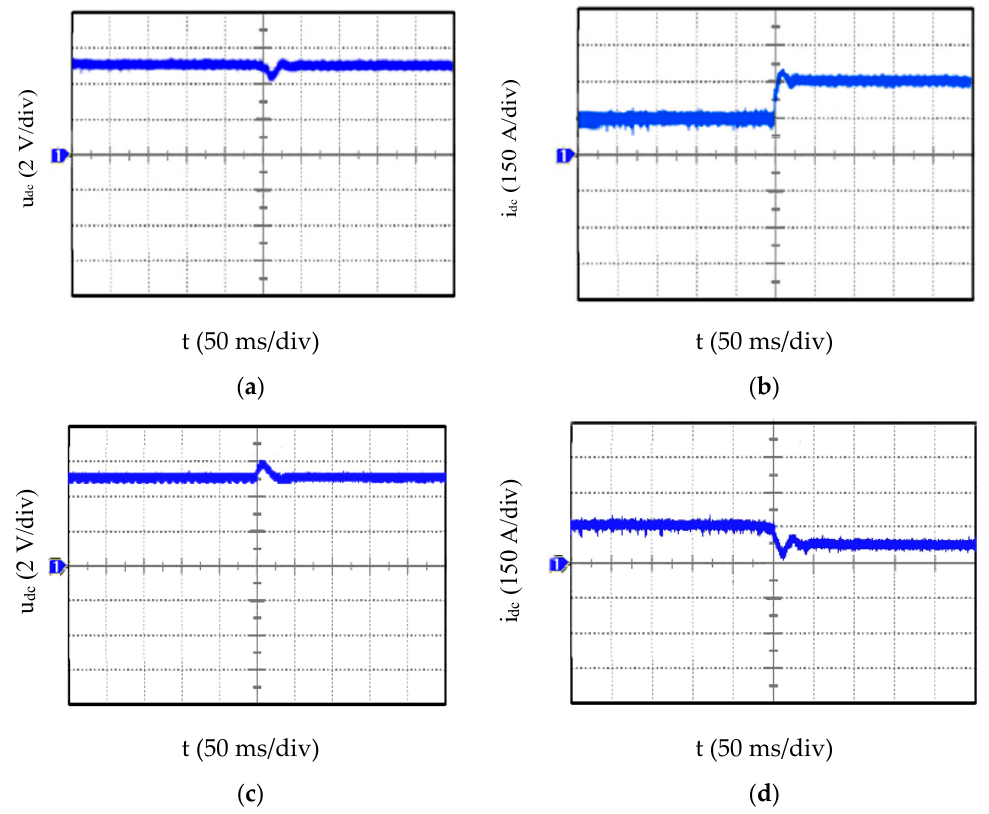
Figure 17. DC output voltage and current waveform: ( a ) voltage waveform when load decreases; ( b ) current waveform when load decreases; ( c ) voltage waveform when load increases; ( d ) current waveform when load increases.